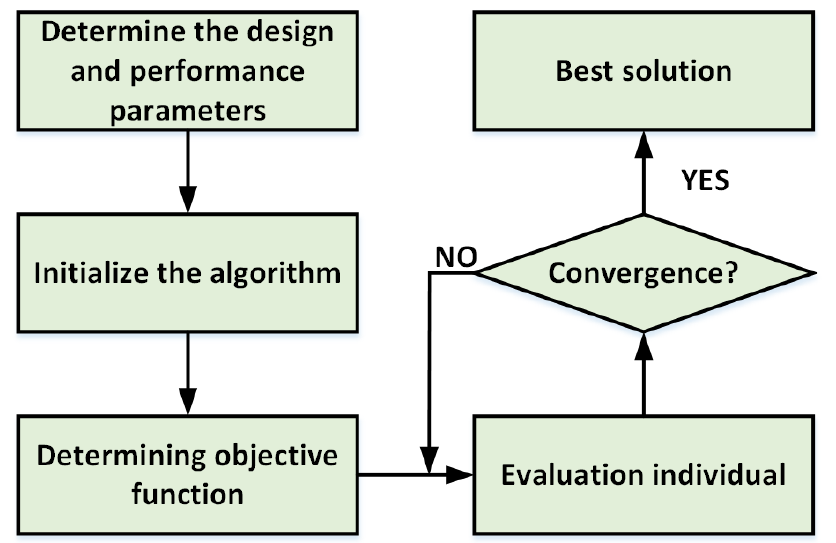
Figure 7. The process of using an AI method to optimize the